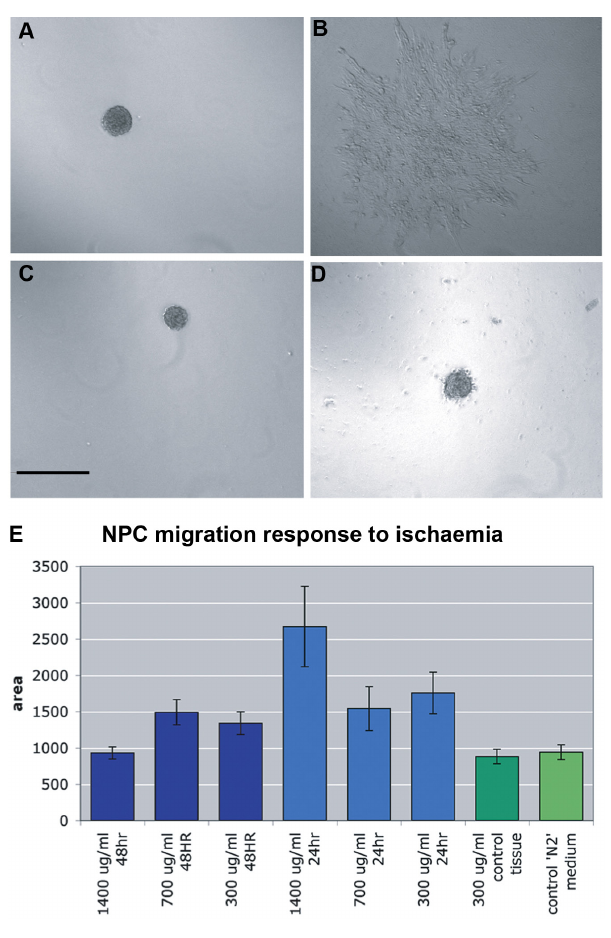
Figure 1. NPC neurosphere response to cerebral ischaemia. A , B , Migration of individual neurosphere in response to 1400 µg/ml protein from 24 hour MCAO homogenate at t=0 hr ( A ) and t=72 hr ( B ). C , D , Migration of individual neurosphere in response to contralateral hemisphere MCAO proteins at t=0 hr ( C ) and t=72 hr ( D ). E , Cell migration from E14 neurospheres at 72 hours with no proteins or treatment with proteins from either normal brain homogenates or from 24 (light blue bars) and 48 (dark blue bars) hours MCAO homogenates at different concentrations; *: p<0.001. Scale bar, 400